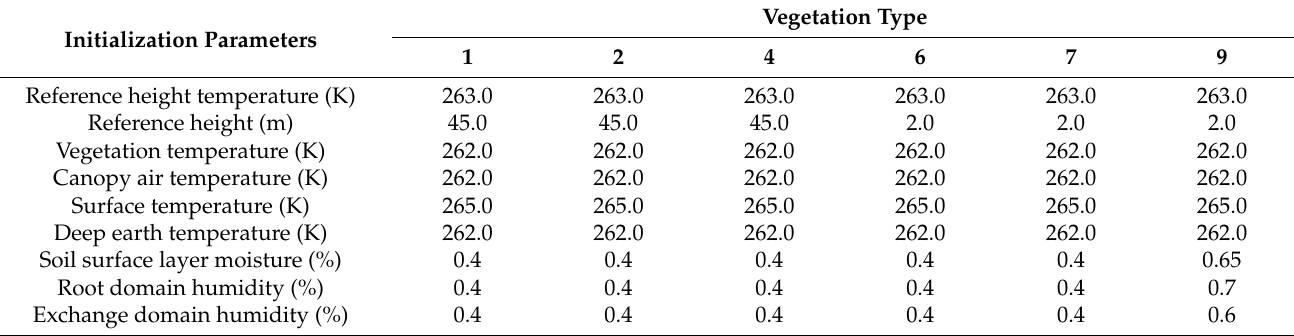
Table A7. Initial parameters of